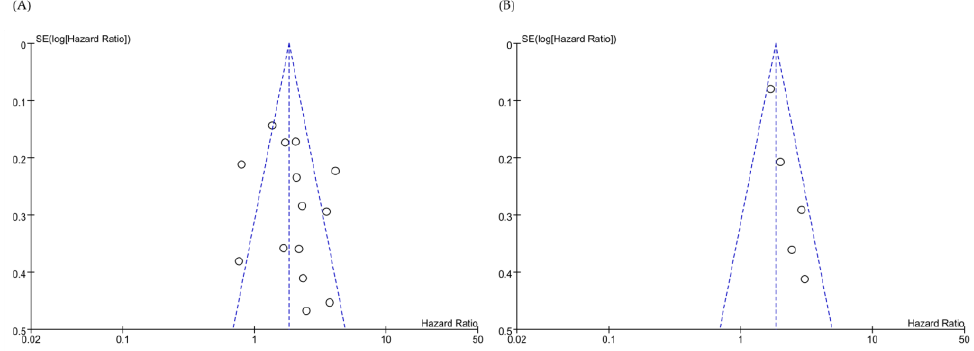
Figure 2. Funnel plot for ( A ) overall survival, and ( B ) progression-free survival, according to ROR1 expression. Dots(o) represent individual studies.